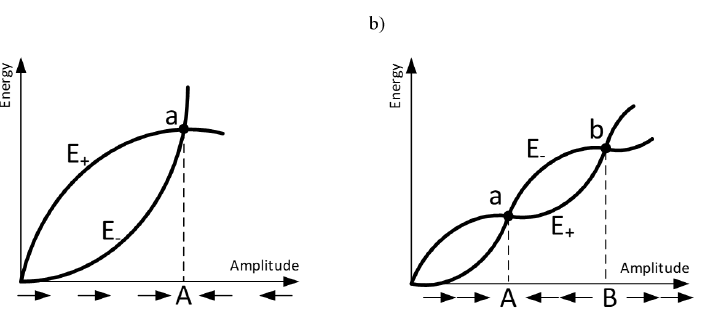
Figure 14. Energy flows during vibrations for ( a ) one stability point; ( b ) multiple stability